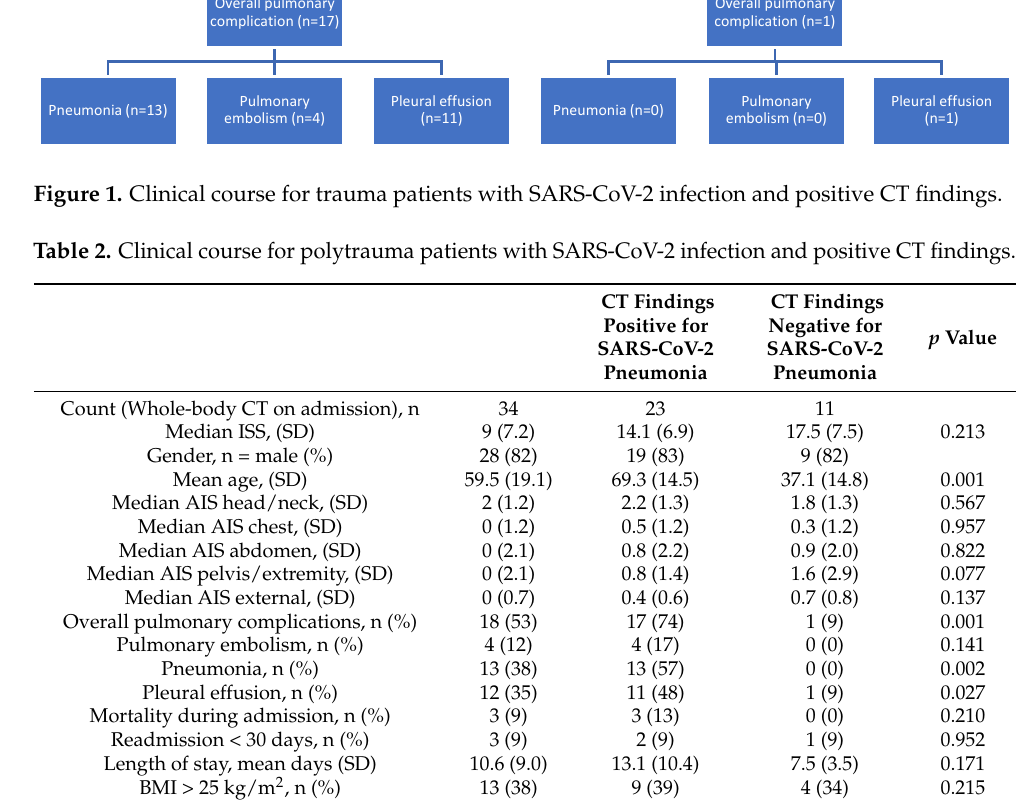
Table 3. Age-adjusted pair-matched analysis of polytrauma patients with SARS-CoV-2 infection and positive CT findings.